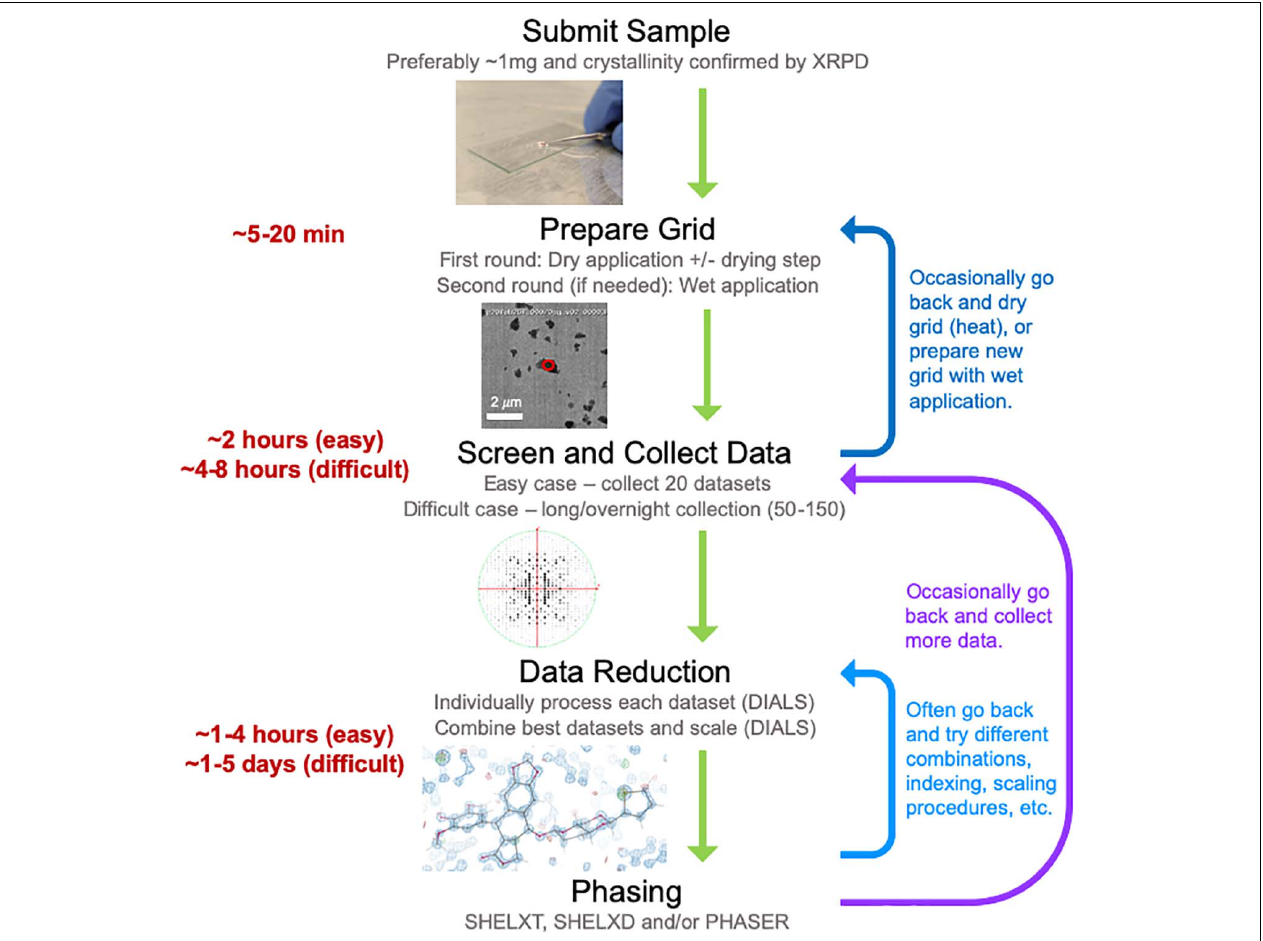
FIGURE 2 | The general workflow pipeline at NIS with typical times given for easy and difficult cases. At the screening and data collection stage, an “easy” target has many crystals that all diffract to high resolution ( ≤ 1.1 Å), while a “difficult” target may be much more heterogeneous in terms of diffraction quality and/or may have been flagged as “difficult” if processing the first couple of datasets revealed problematic features (low resolution, radiation damages and/or low completeness upon merging datasets). Data processing, encompassing both data reduction and phasing, is a very iterative process where many data reduction strategies are typically employed before successful phasing can be